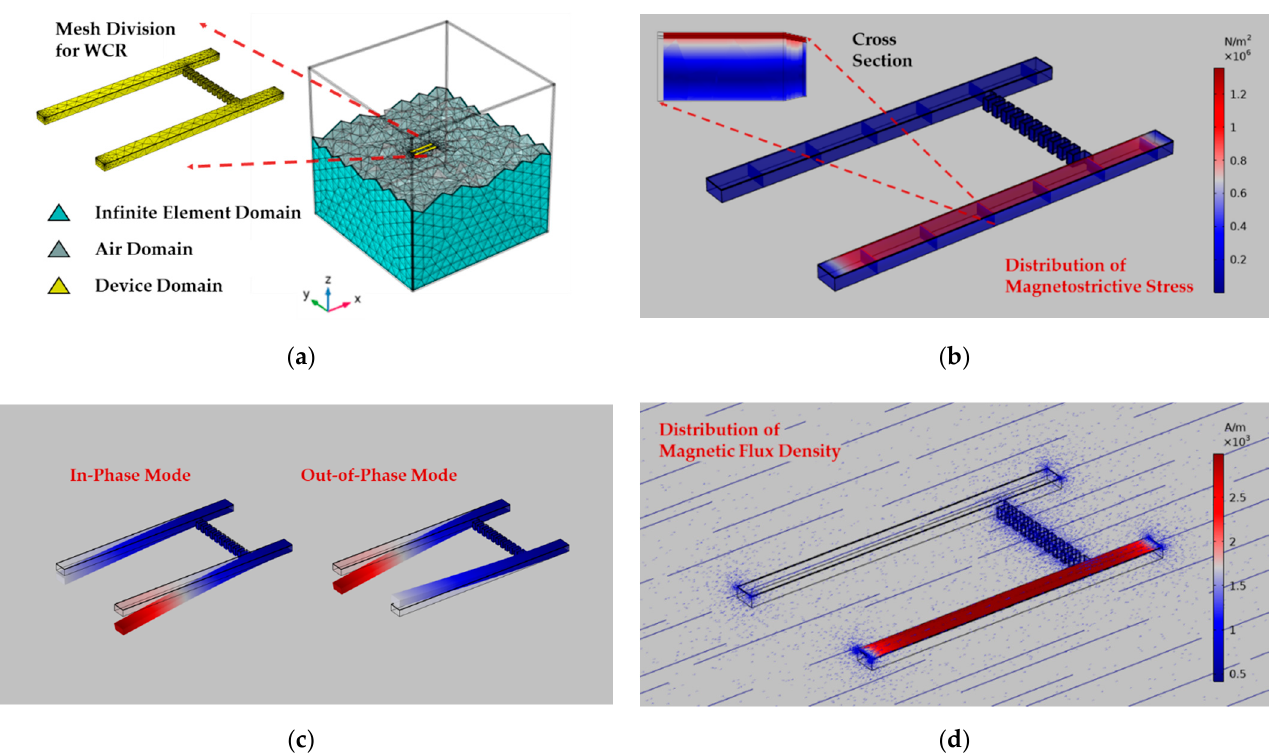
Figure 3. The FEM simulation for the WCR: ( a ) the WCR meshing diagram and the model is divided into an air domain, an infinite element domain, and a device domain (zoom-in); ( b ) stress distribution of the folded-beam mechanically coupled WCR under the 1 mT DC magnetic field along the x -axis; ( c ) driving Resonator 2 piezoelectrically, the out-of-phase and the in-phase vibration modes of the WCR; ( d ) magnetic flux density distribution map of the WCR and the convergence within the magnetic film